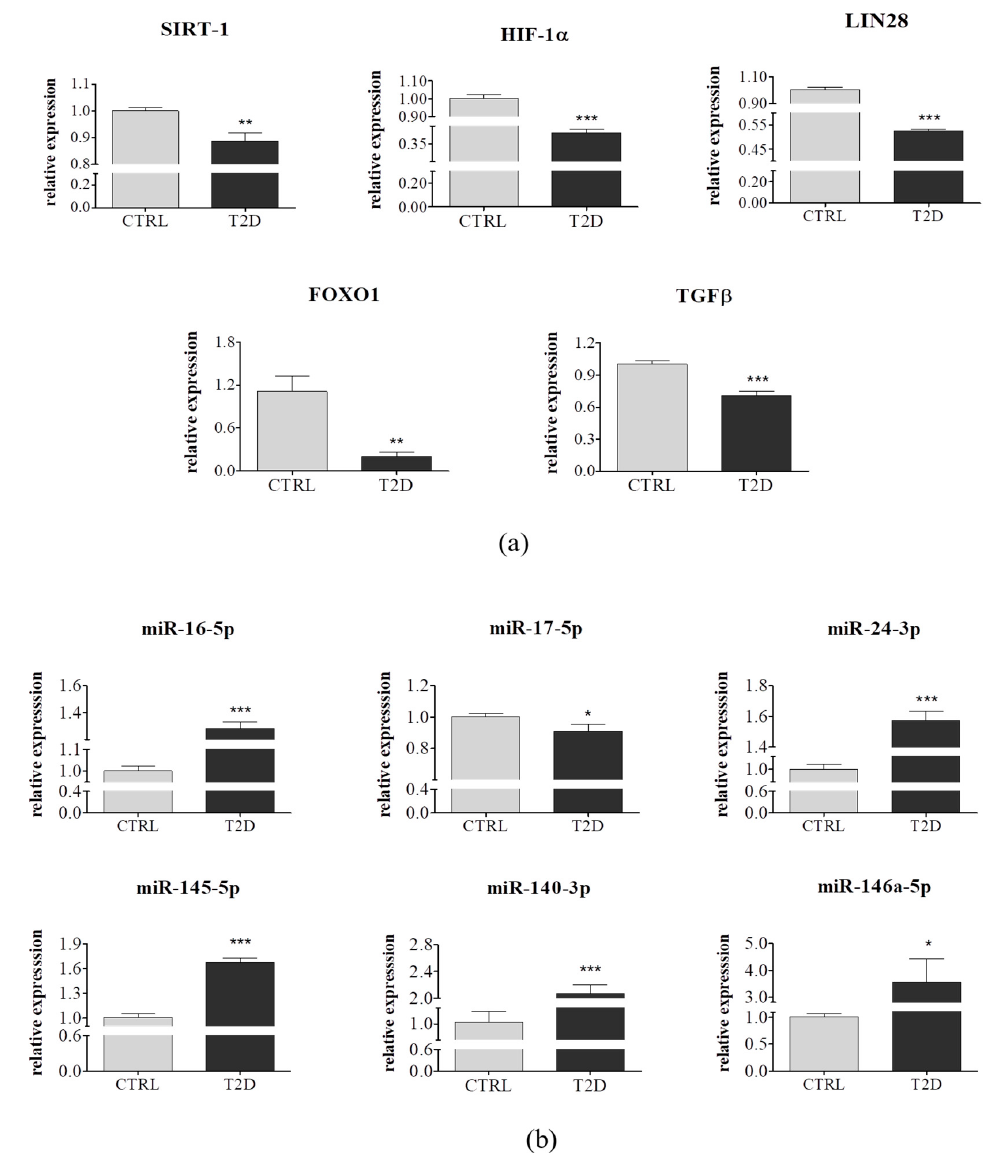
Figure 4. Transcripts levels of selected mRNA and miRNA in ASCs derived from a control group ( n = 6) and from type 2 diabetic individuals ( n = 6). ( a , b ) Both, mRNA and miRNA expression profiles were determined using quantitative PCR. Results are expressed as mean ± SD. Statistical significance are indicated by asterisks (*): * p < 0.05, ** p < 0.01, and *** p < 0.001 were examined by unpaired Student’s t -test.